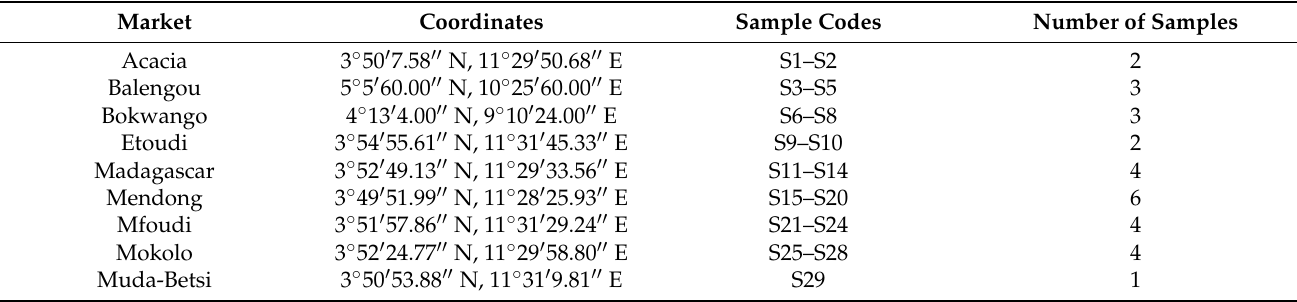
Table 1. Number of geophagic clay samples per